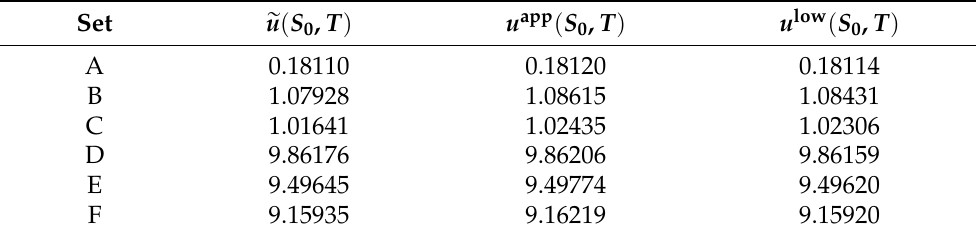
Table 2. Reference values r u p S 0 , T q , u app p S 0 , T q , u low p S 0 , T q for American basket put